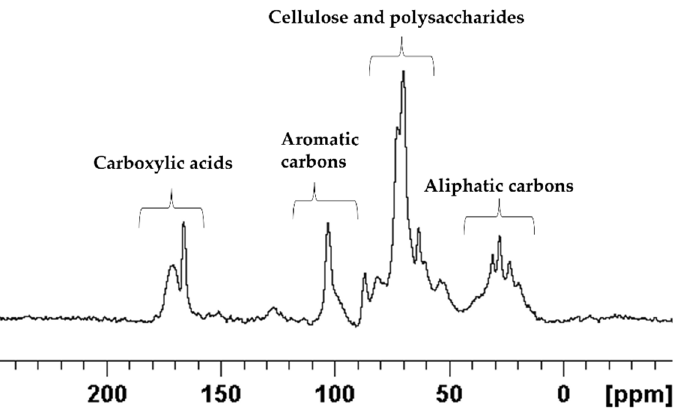
Figure 4. 1D 13 C spectrum of E. foeminea plant powder recorded using 600 MHZ solid-state NMR. The assignments of the E. foeminea solid-state NMR spectrum and the calculated ra-